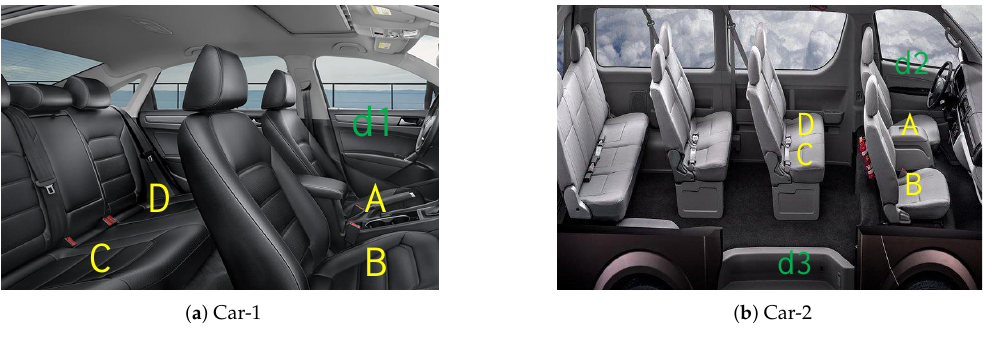
Figure 6. Car interior plan and locations of closing